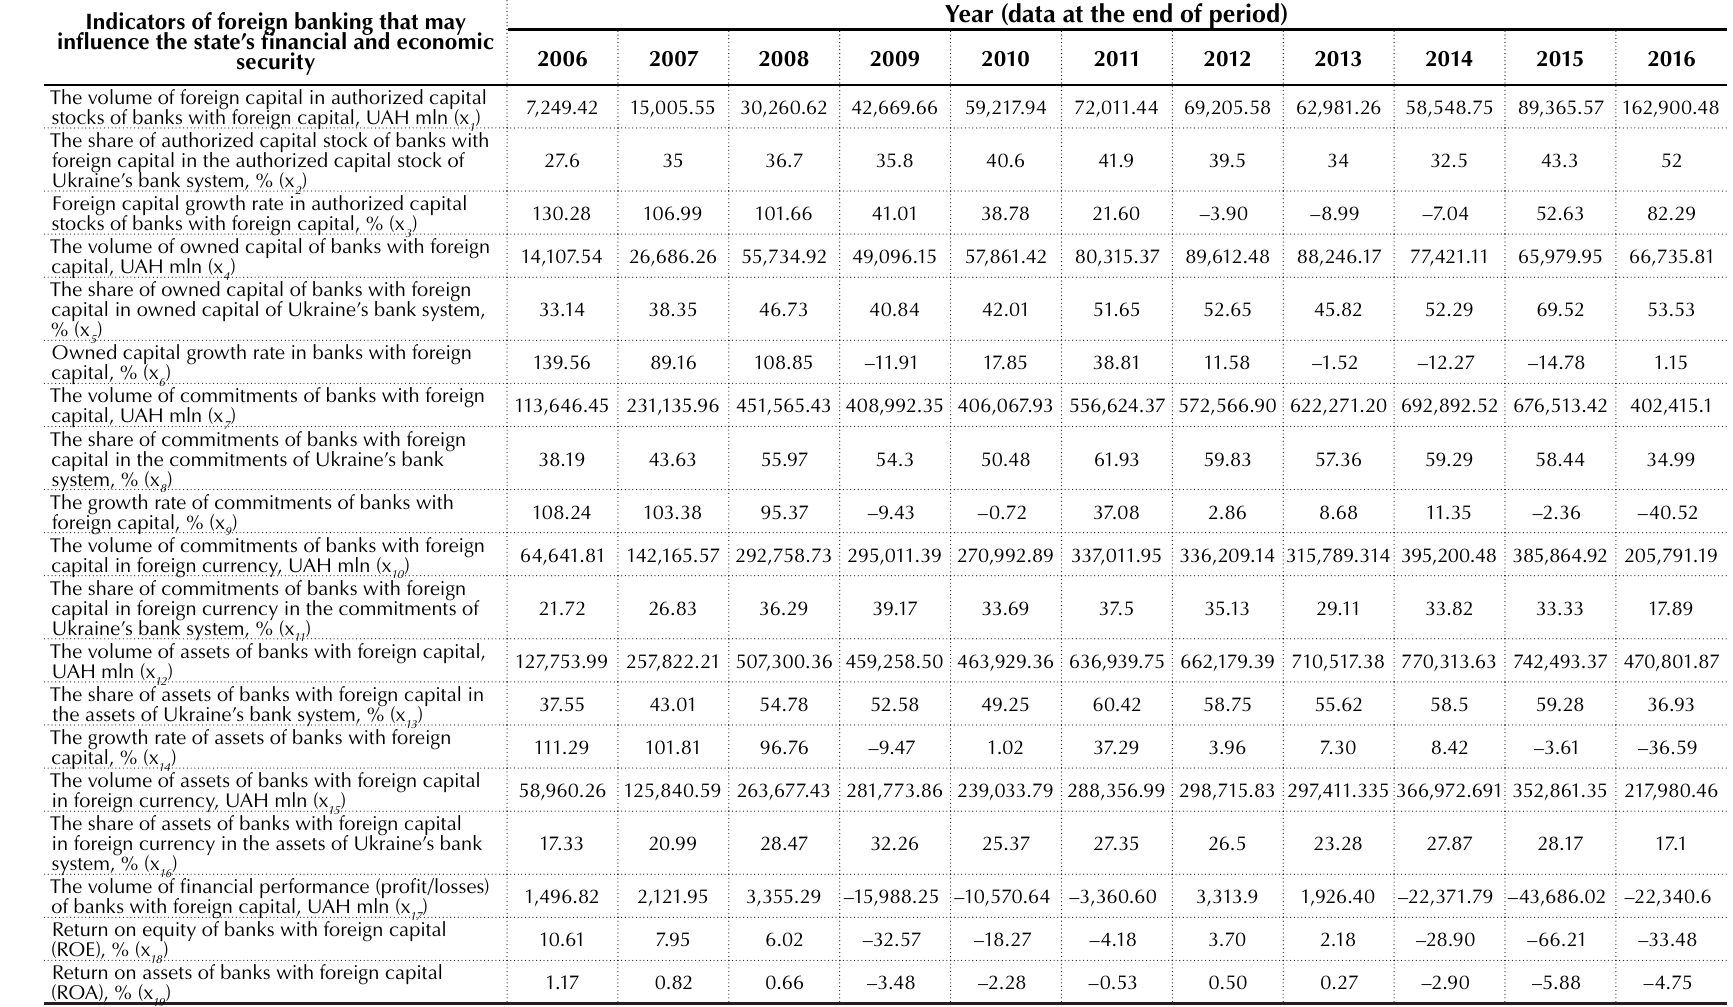
Table 2A. Indicators of foreign banking that may influence the state’s financial and economic security (factor indicators/exposure) to be used for the construction of the correlation and regression model Source: Calculated and developed by authors according to the data of the National Bank of Ukraine (2017), the National Rating Agency ‘Riuryk’.